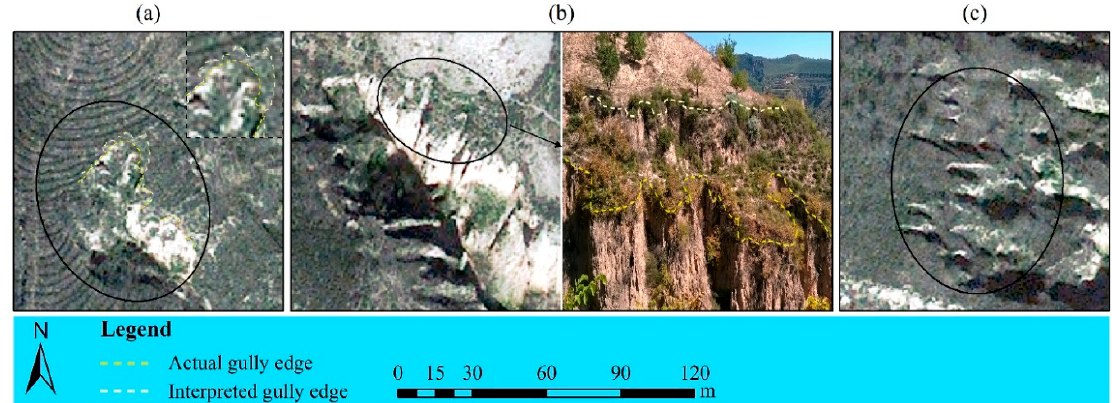
Figure 7. Broken topography in the Loess Plateau mainly caused under three cases. ( a ) Periodical erosion of runoff to original loess surfaces; ( b ) varying anti-erodibility between different loess layers; ( c ) abiogenetic mass failure such as landslide, fault, collapse and so on. The Pleiades image was displayed as true color composite with a spectral band combination of B2, B1 and B0 assigned to red, green and blue, respectively.